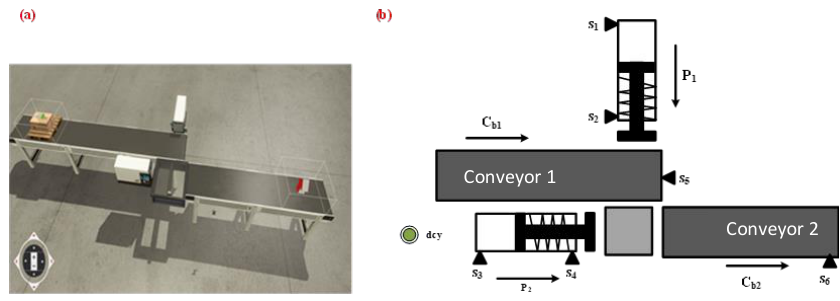
Figure 7. ( a ) boxes transfer system, ( b ) the system’s actuators and sensors.